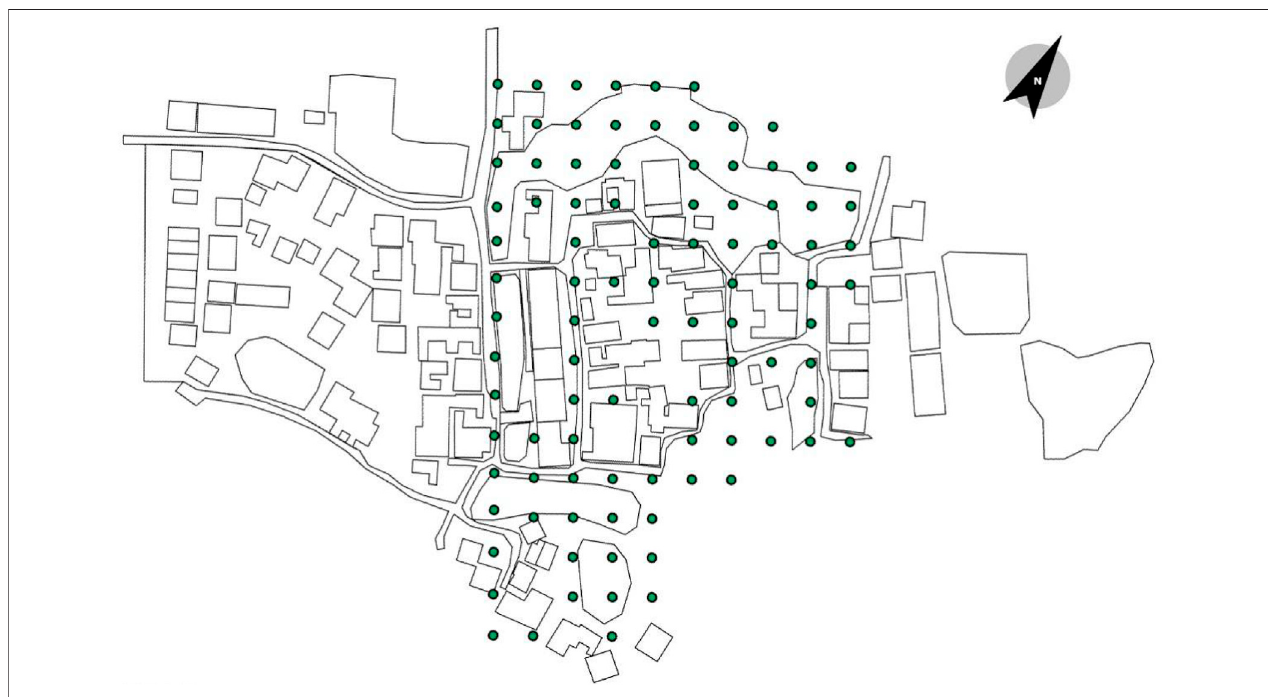
FIGURE 4 | Village con fi guration and data extraction points in ArcGIS.